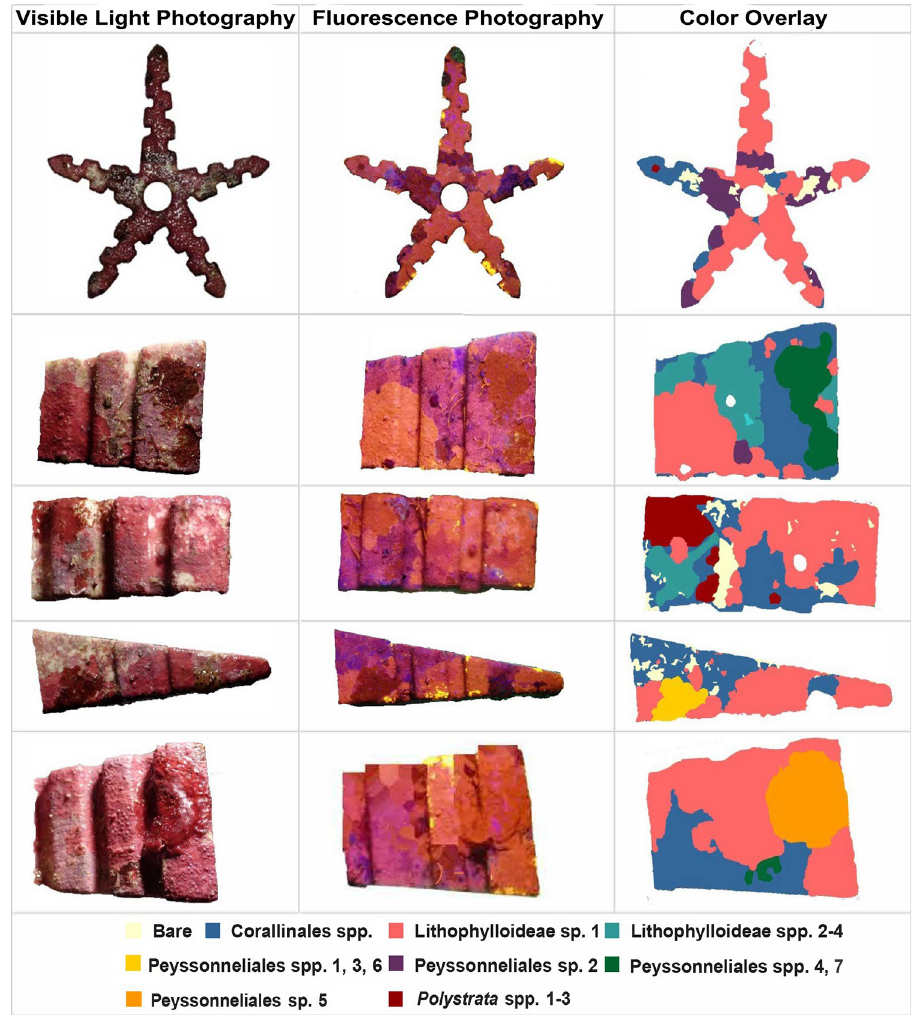
Fig 1. Example of coral recruitment tile photographs under visible light and actinic light plus the color overlay used for the calculation of percent cover for each substrate category. Benthic cover was assessed for all 11 exposed sides of the 12 tiles. Substrate category colors are the same as in Figs 4 and